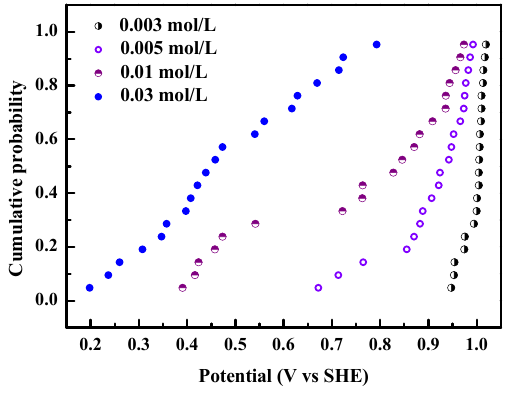
Figure 6. Cumulative probability distribution of pitting potential of steel bar under different chloride concentration at pH 12.0.